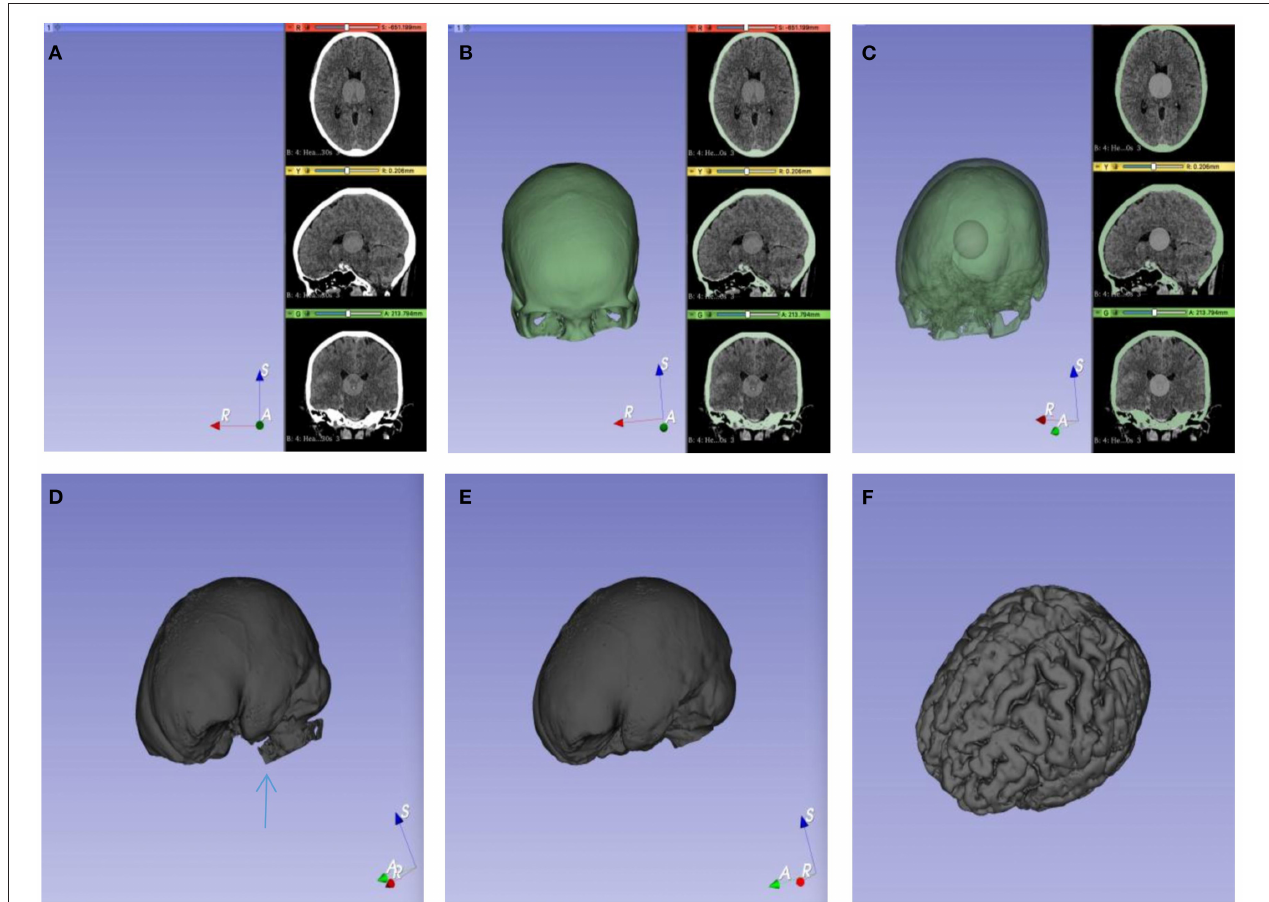
FIGURE 3 | Calculation process of brain volume (BV). (A) A gray sphere was drawn in the center of the cranial cavity as the initial value. (B) The inner surface of the skull was defined as the outer boundary of the target segmentation image. (C) The initialization of segmentation started from the initial value and then iteratively filled. (D) The pore structure of the skull base is shown, and a little pixel leakage may be occurred (blue arrow). (E) The volume of the cranial cavity was obtained after the leakage was removed with tools. (F) Pixel threshold technology was used to remove non-brain tissue.